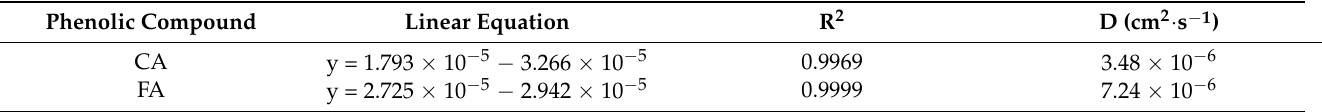
I pa = 268, 600 × n 3/2 × A × D 1/2 × Cv 1/2 The results obtained are presented in Table 1. Table 1. Linear equations, R 2 and diffusion coefficients of CA and